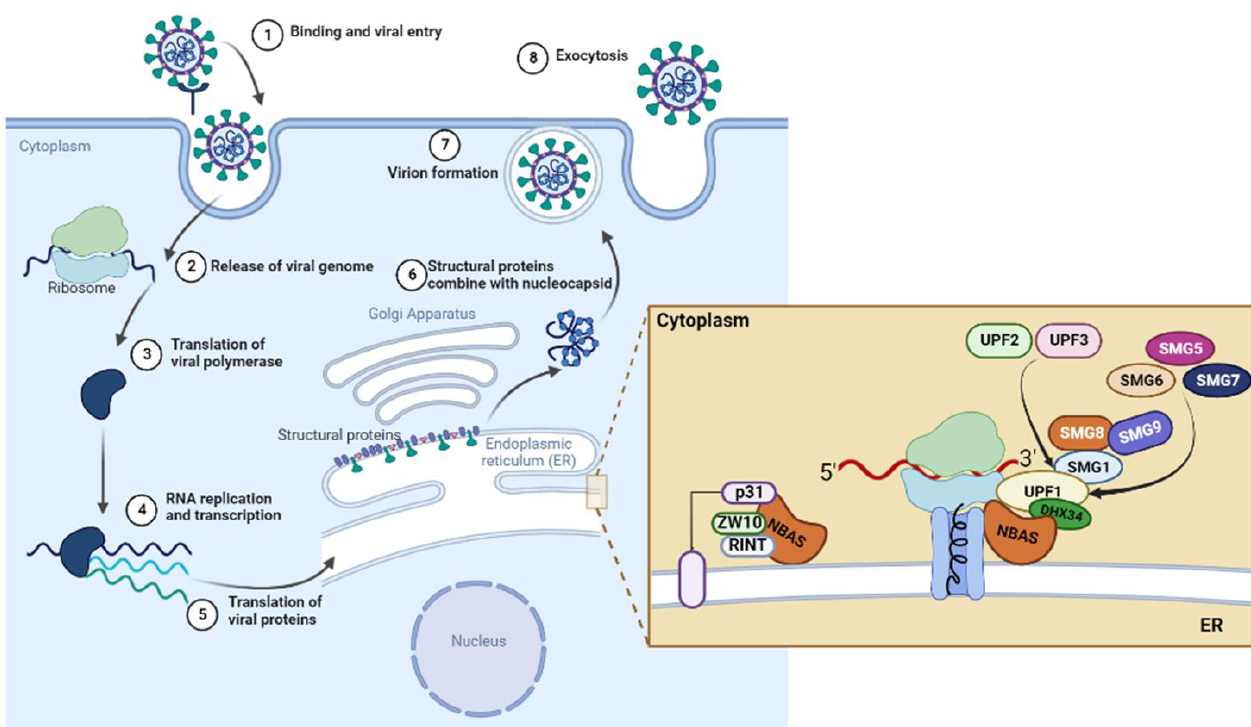
Figure 1. Schematic representation of SARS-CoV-2 infection and replication cycle in host cells. Zoom on cellular mechanisms involving NBAS protein herein investigated. The figure was created with BioRender.com (accessed on 12 December 2022).